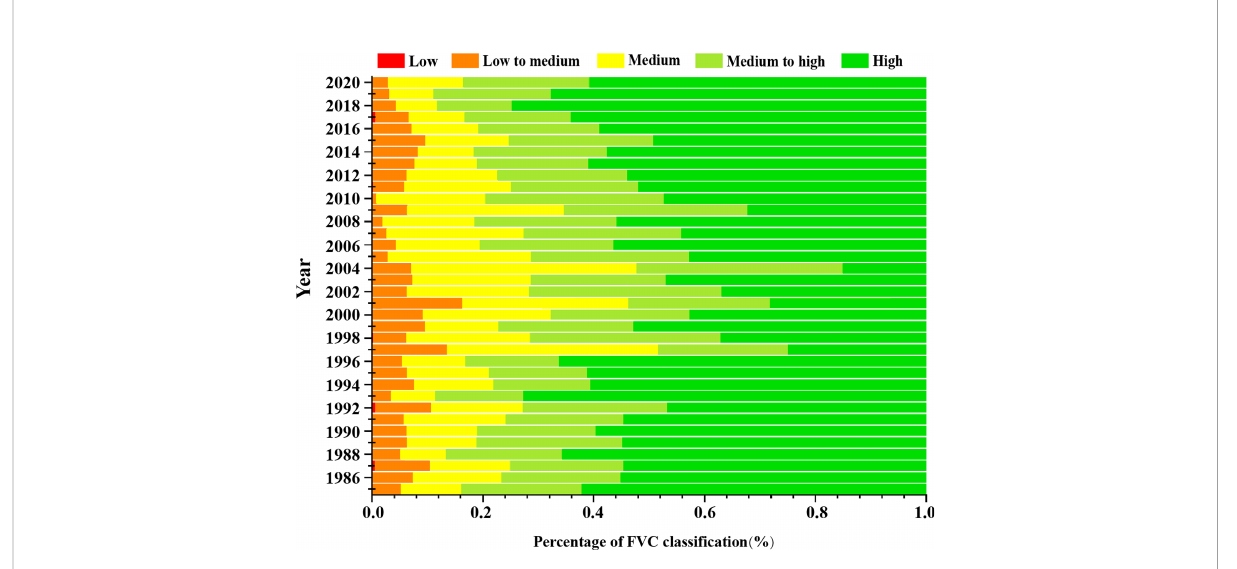
FIGURE 3 The proportion of FVC of different grades in the study area from 1984 –